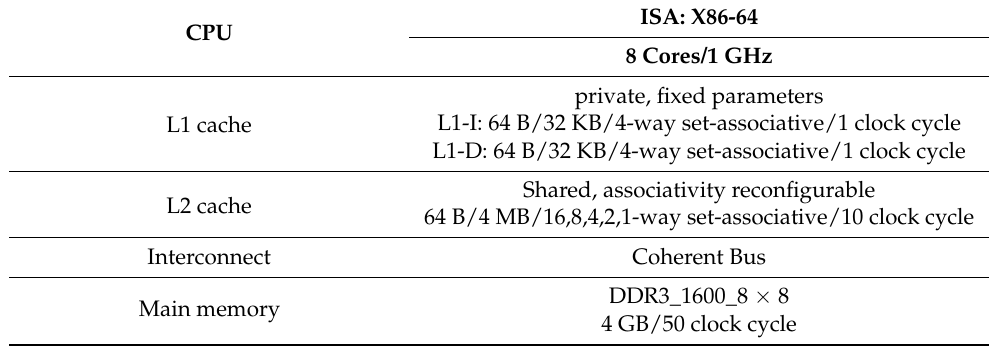
Table 1. Configuration of the GEM5 simulator.